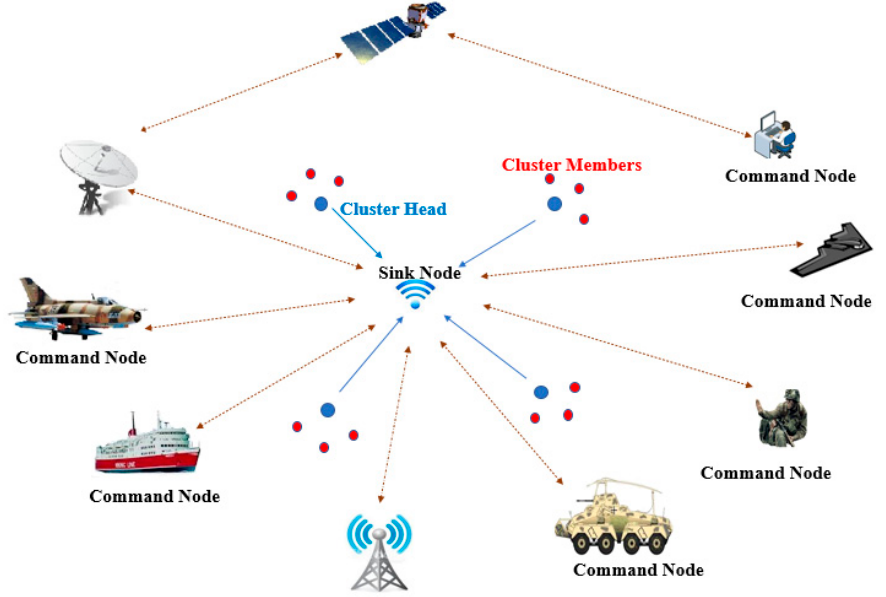
Figure 2. Military architecture for monitoring application using the single-hop clustering model in WSNs.